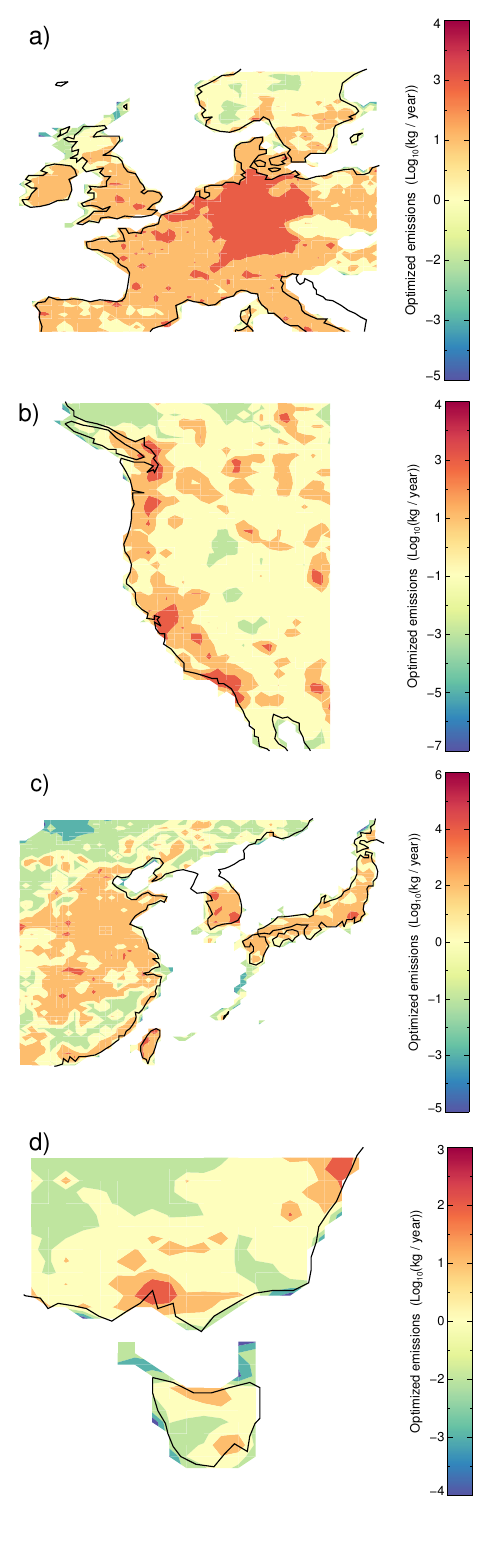
Fig. 5. Optimized SF 6 emissions surrounding (a) Mace Head, Ire- land, (b) Trinidad Head, California, (c) Gosan, South Korea, (d) Cape Grim,